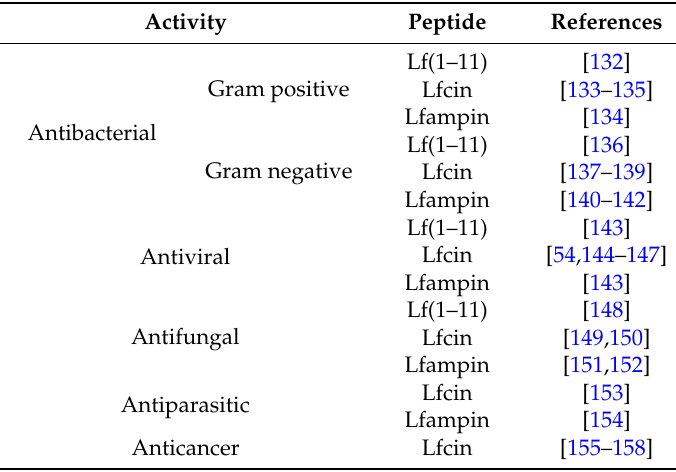
Table 2. Biological activities of lactoferrin